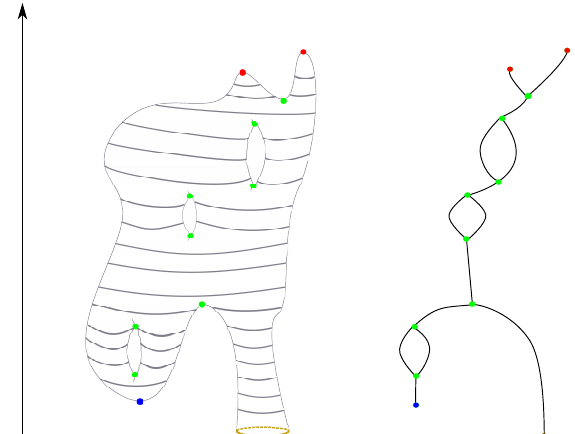
Figure 2. An example of a Reeb graph (right) of a scalar function (left) defined on a surface with a boundary.